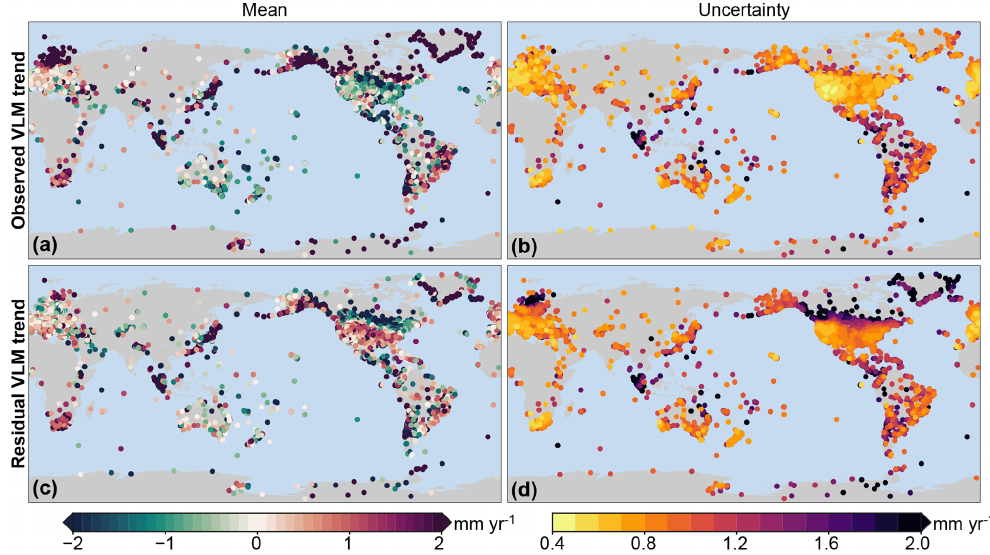
Figure 10. Observed VLM and residual VLM trends from GNSS records. (a, b) The trend in observed VLM and associated uncertainty. (c, d) Trends in residual VLM after removing the SED effects due to GIA and contemporary mass redistribution. All trends have been computed over the time spans for which GNSS and GRACE observations